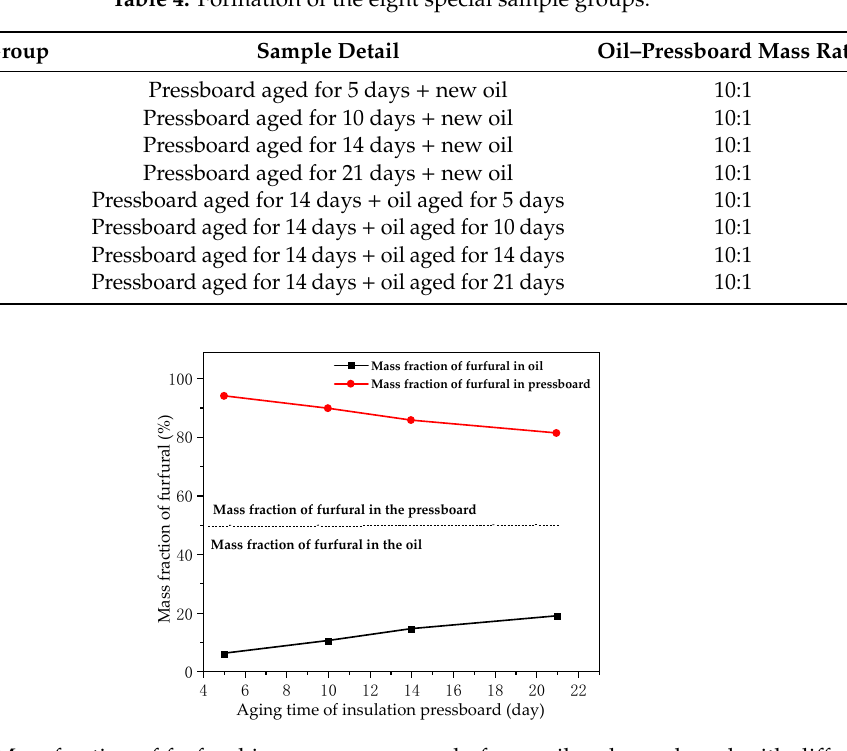
Table 4. Formation of the eight special sample groups.